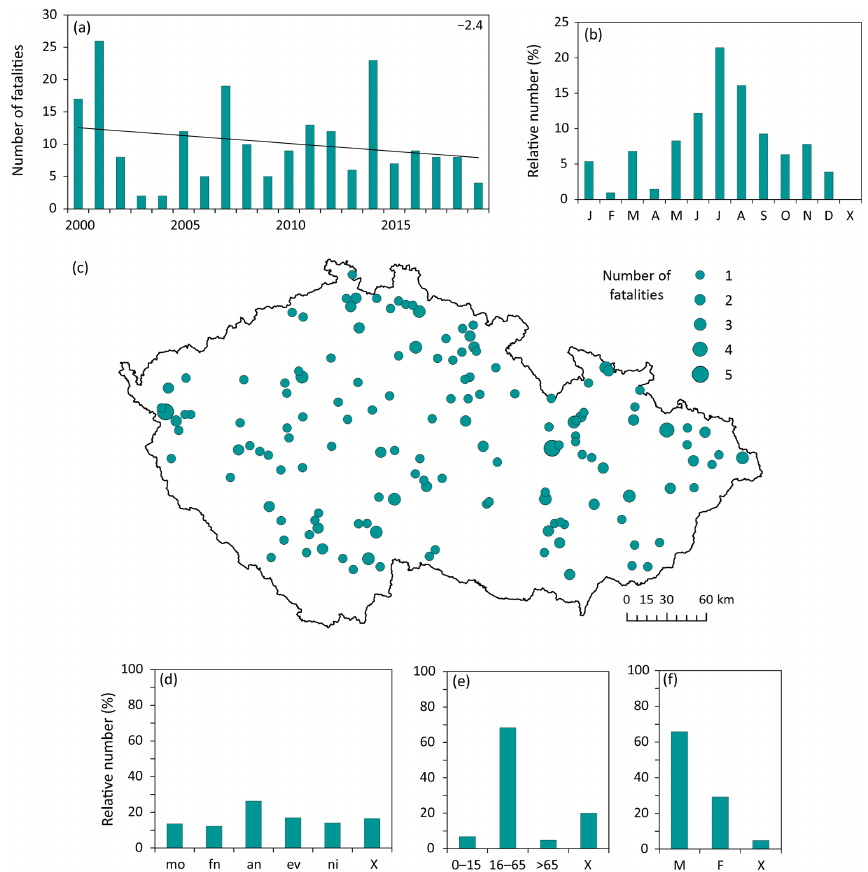
Figure 4. Characteristics of rain-related fatalities in the Czech Republic during the 2000–2019 period: (a) fluctuation with linear trend (top right, fatalities/10 years), (b) annual variation, (c) spatial distribution (four fatalities lack exact location), (d) part of the day, (e) age, (f) sex. For explanation of symbols and abbreviations see Fig.